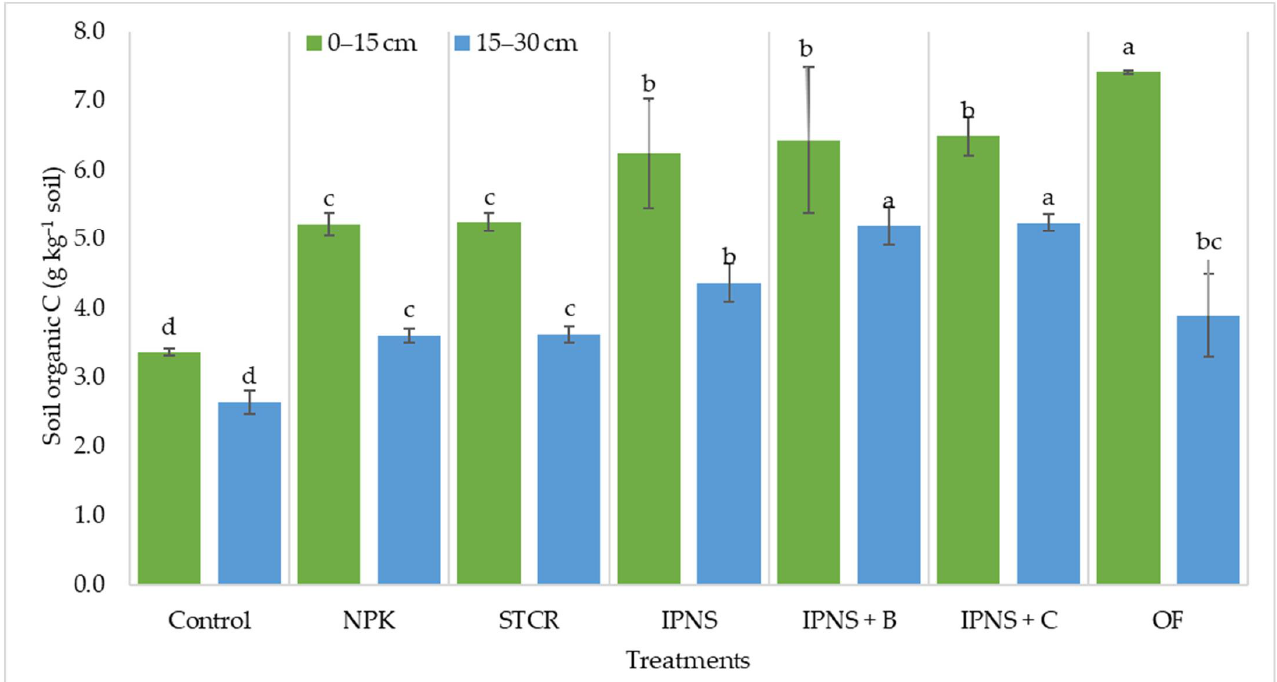
Figure 4. Effect of nutrient management on Walkley–Black carbon. Means ± standard deviation of different treatments followed by the different lower-case letter (a–d) are significantly different at p < 0.05 level of significance according to DMRT.